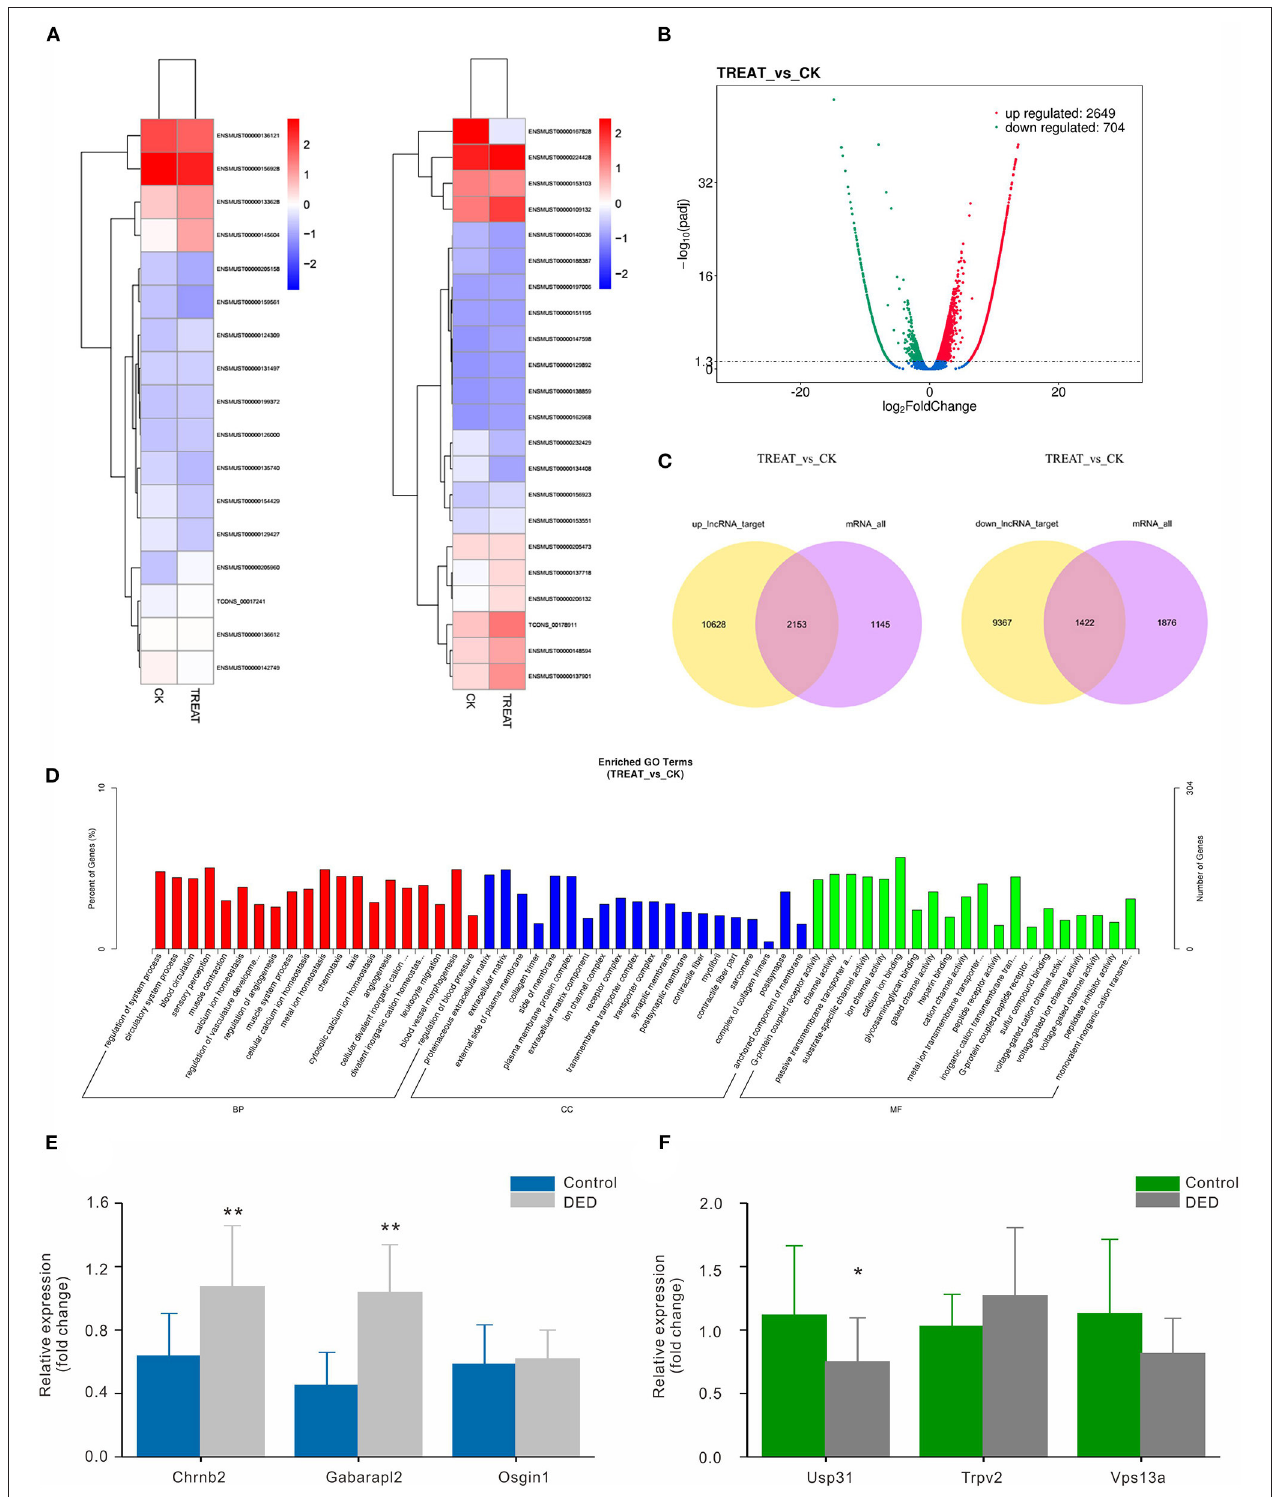
FIGURE 3 | Bioinformatic functional analysis of differentially expressed lncRNAs. (A) Heatmap of expression levels of tissue-specific lncRNAs. (B) Volcano plot of the different lncRNAs expression in each group. (C) Venn diagram showing co-location or co-expression of lncRNA-target genes (mRNAs). (D) The number of differentially expressed lncRNAs in BP, CC, and MF. (E) Expression levels of the top three upregulated lncRNAs in both groups via RT-qPCR. (F) Expression levels of the top three downregulated lncRNAs in both groups via RT-qPCR. CC, cellular component; MF, molecular function; BP, biological process. * p < 0.05, ** p < 0.01. DED, dry eye